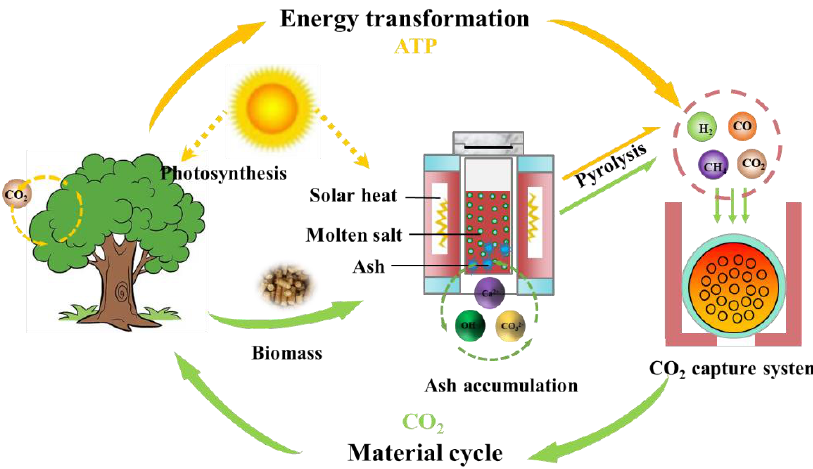
Figure 11. Main negative carbon reaction pathways of bio-waste pyrolysis in molten salts.